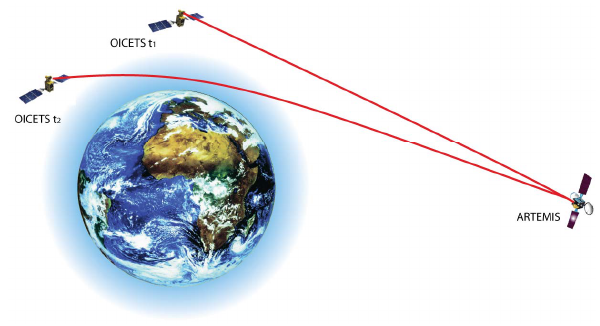
Figure 1 Observation geometry of the communication experiment between ARTEMIS and OICETS on 5 April 2006.